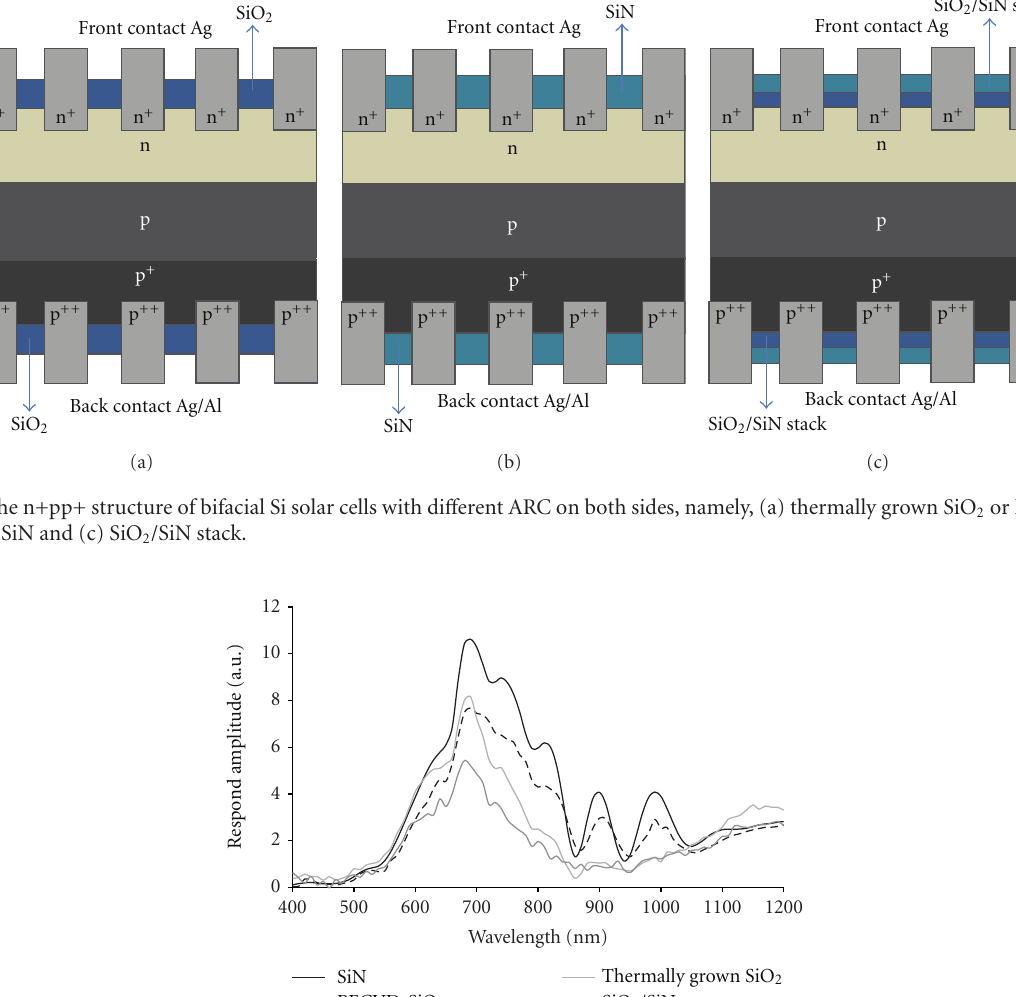
SPV measures the minority carriers (i.e., electrons for